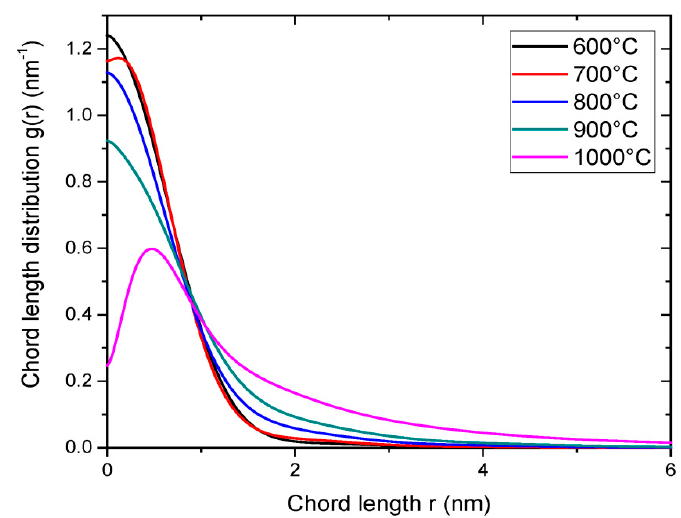
Figure 7. Analysis of the CDCs by SAXS. The chord length distribution g ( r ) derived from SAXS data (see Figure 4) is plotted against the length of the chords. The color coding in the graph refers to the different temperatures at which these CDCs have been synthesized (see also the discussion of Figure 6 above). Reproduced with permission from [75] copyright © 2019, Elsevier. Table 1. The comparison of structural parameters deduced from SAXS measurements of different carbonaceous materials: The three dimensional fluctuation of scattering contribution B fl , invariant Q m , Porod constant P m , inner surface area S , porosity φ , number-average chord length l P , mean chord length of the pore (cid:104) l pore (cid:105) and the carbon matrix (cid:104) l solid (cid:105) , weight-averaged chord length l c , ansiometric ratio l c / l SAXS p , lateral correlation length l R , degree of angularity g ( 0 ) , and the degree of disorder (cid:104) ∆ 2 a (cid:105) © 2019, + (cid:104) ∆ 2 l R (cid:105) 3 (cid:104) a (cid:105) 2 (cid:104) l (cid:105) 2 . Reproduced with permission from [73–75] copyright 3 R